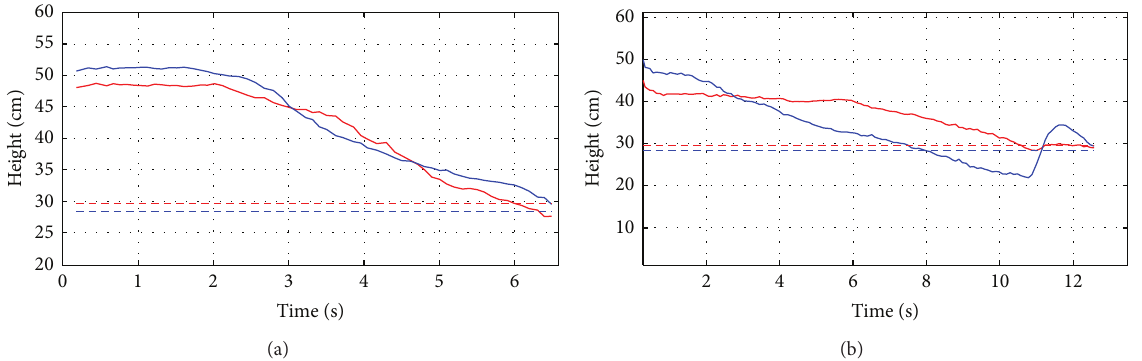
Figure 8: Sample hand heights for the haptic verbal (a) and haptic (b) condition: solid blue line is the leader’s hand position and solid red line is the follower’s hand position.